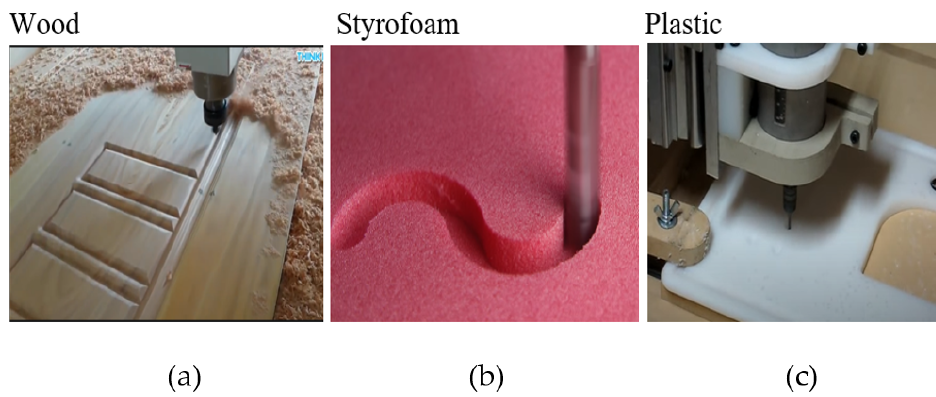
Figure 7. Operation Materials of ( a ) CNC milling process on wood [36] Accessed on 2019, December 10. ( b ) CNC milling process on Styrofoam [37] Accessed on 2019, December 10. ( c ) CNC milling process on plastic [38] Accessed on 2019, December 10.